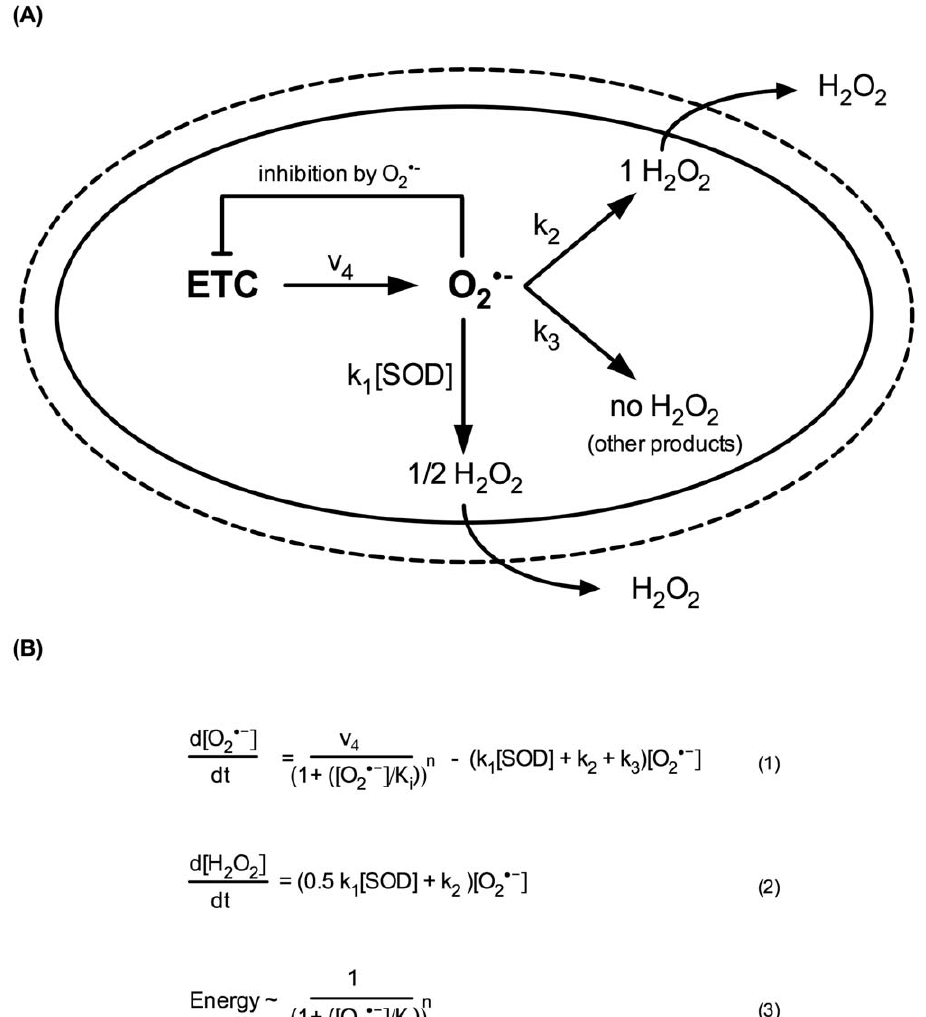
Figure 7. Minimal model for mitochondrial superoxide production and consumption and hydrogen peroxide production. Model based on that of Gardner et al. [37,50], modified for the mitochondrial compartment. A ) Three classes of superoxide consumption reactions with different hydrogen peroxide yields are considered. Each class represents a large number of actual reactions yielding either 1, 1/2 or no hydrogen peroxide per superoxide consumed. The model includes a simple negative feedback mechanism of superoxide on its own production rate. N B ) Equations for production and consumption of superoxide and hydrogen peroxide according to the model. Hydrogen peroxide, but not 2 ]/dt=0). The actual rate of superoxide production is v N superoxide, can exit the mitochondria, and therefore, only equation (1) is steady state (d[O 2 4 / 2 ]/K n , where the denominator models the feedback inhibition of superoxide negatively modulating its own rate of production. The strength (1 + [O 2 i ) of this feedback is controlled by the exponent n, while the threshold at which feedback becomes significant is controlled by the inhibition constant K i . For n=0, there is no feedback inhibition at any level of superoxide while, for n=1, superoxide production is K maximal if superoxide levels are equal to